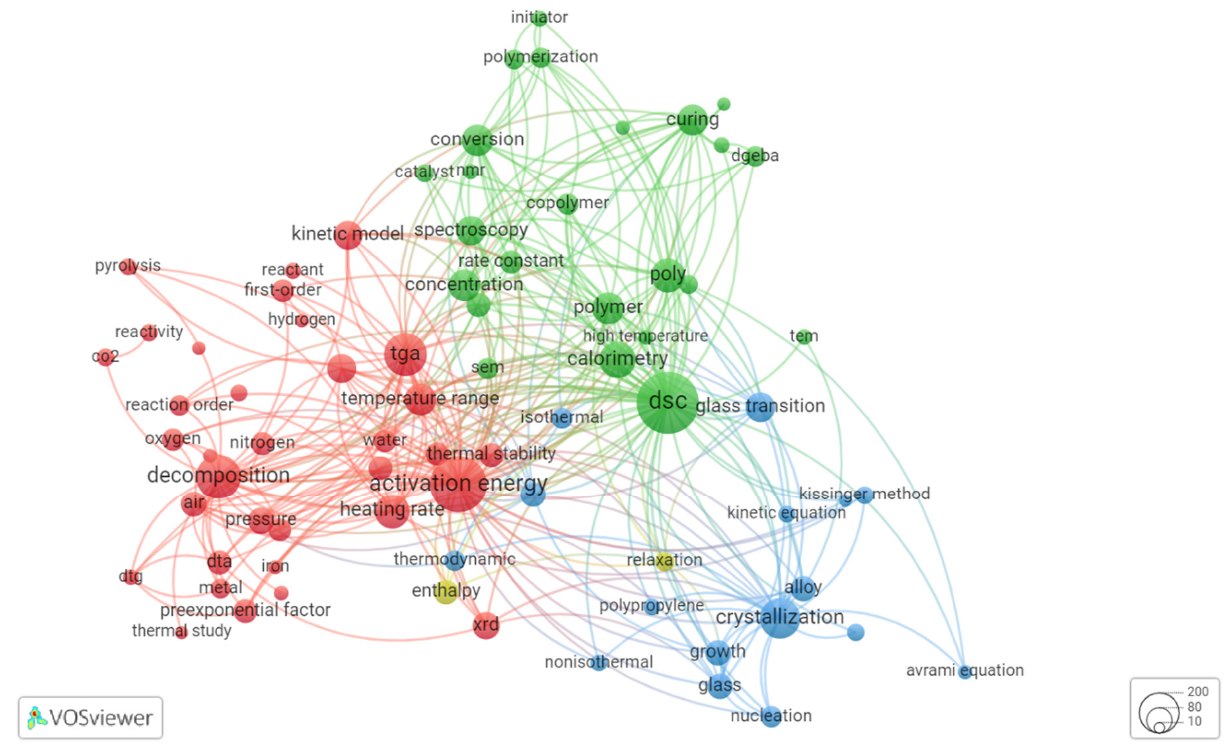
Figure 3. Co ‐ occurrence of keywords extracted from thermokinetic papers published at 2000 (78 keywords occurred at least 10 times in the title and abstract).